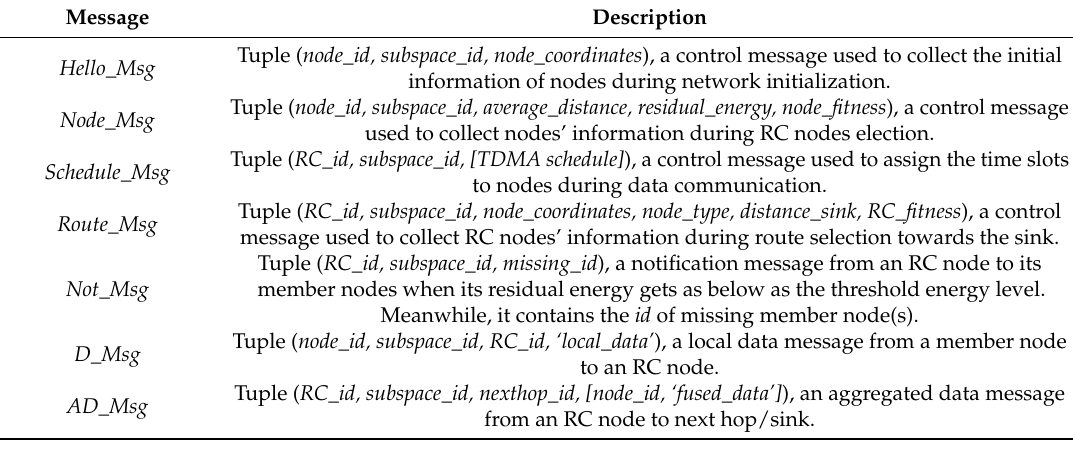
Table 1. Description of control and data